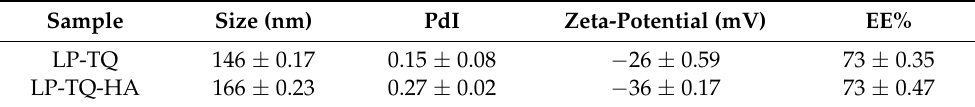
Table 1. Physical and chemical characterization of TQ-loaded conventional liposomes (LP-TQ),